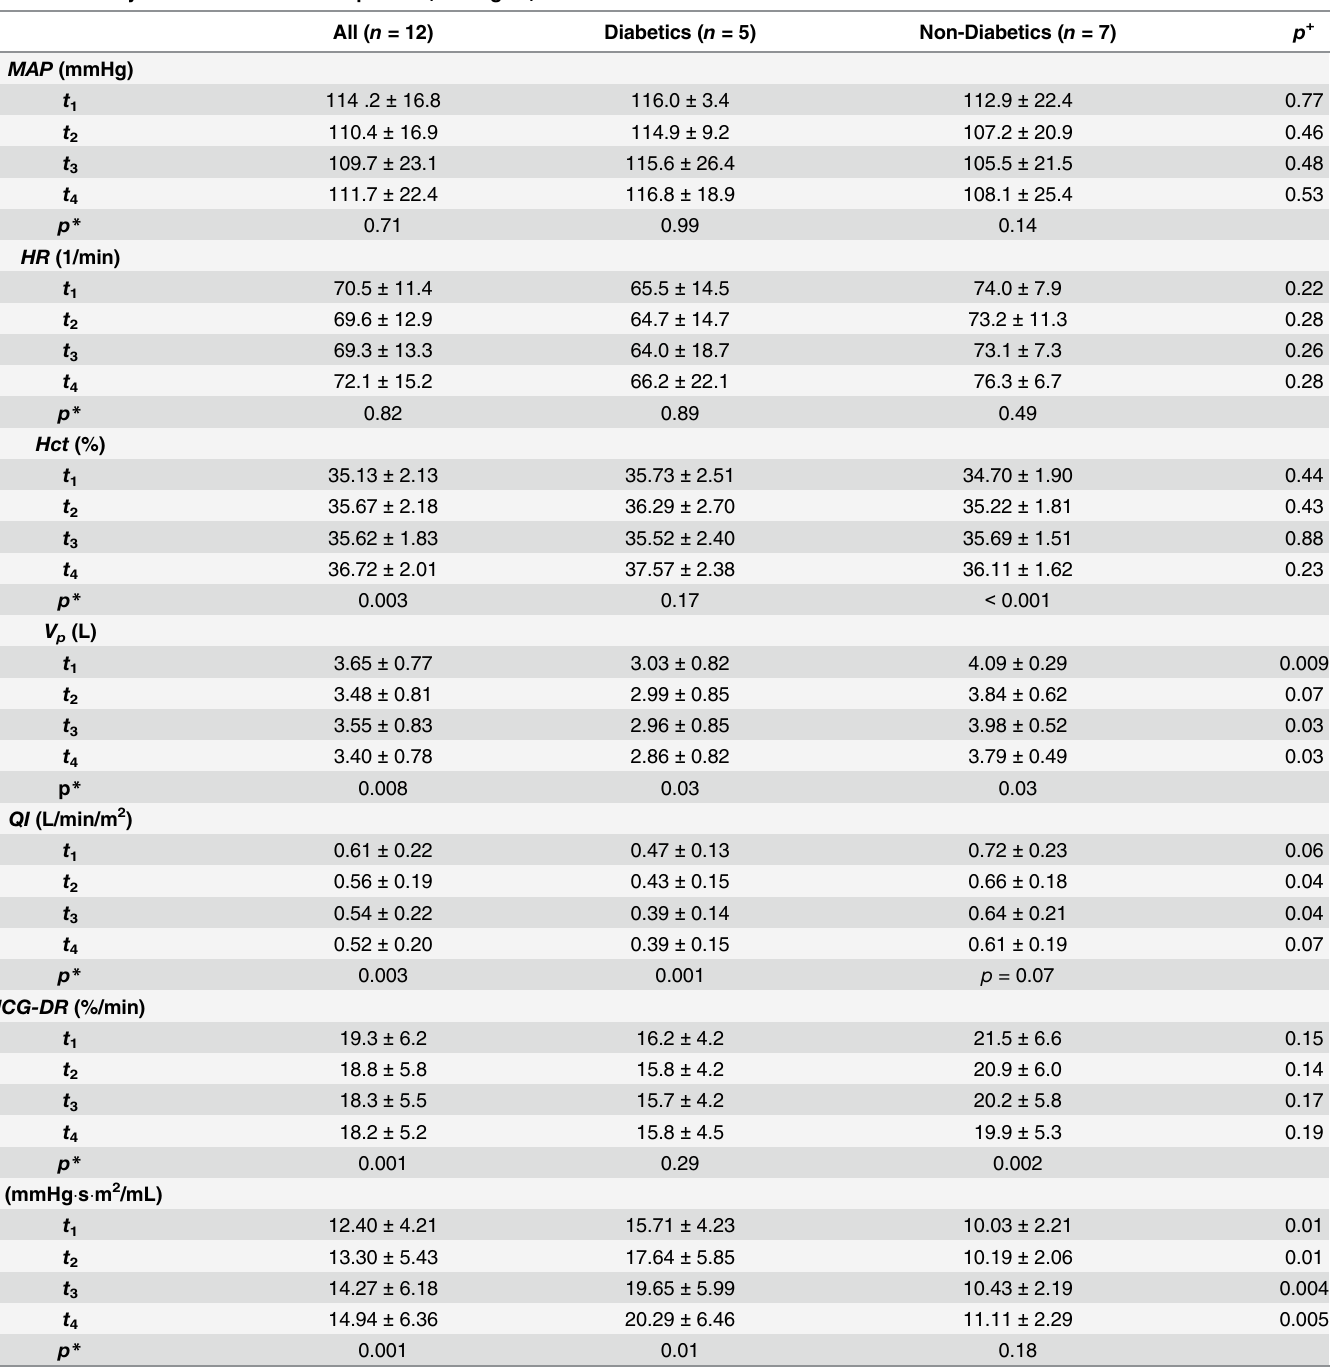
Table 2. Hemodynamic variables at time points t 1 through t 4